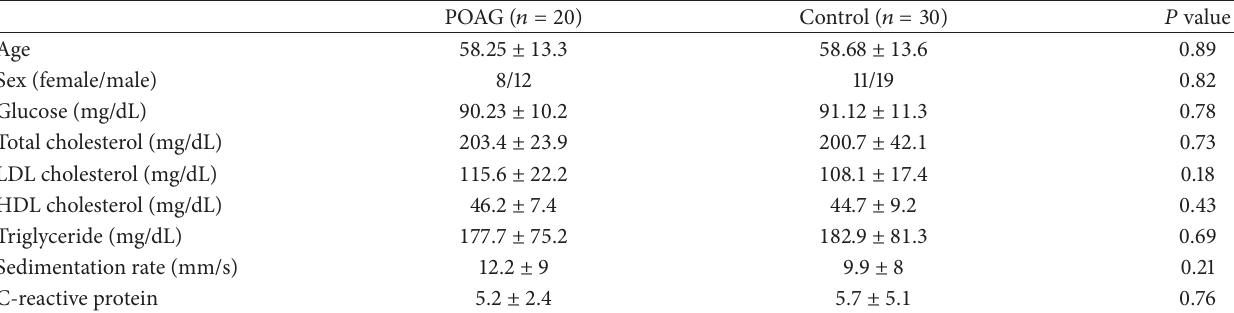
Table 1: Demographic findings and blood measurements.